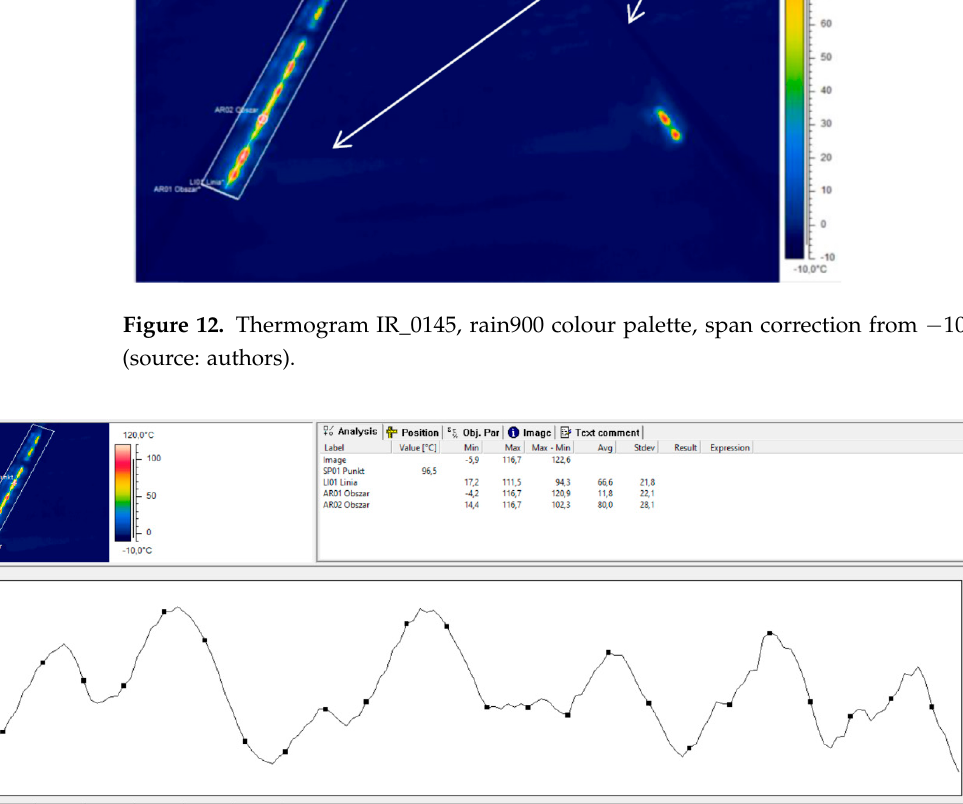
Figure 13. Thermogram IR_0145, rain900 colour palette, the temperature profile for line L01 tool is shown (source: authors).